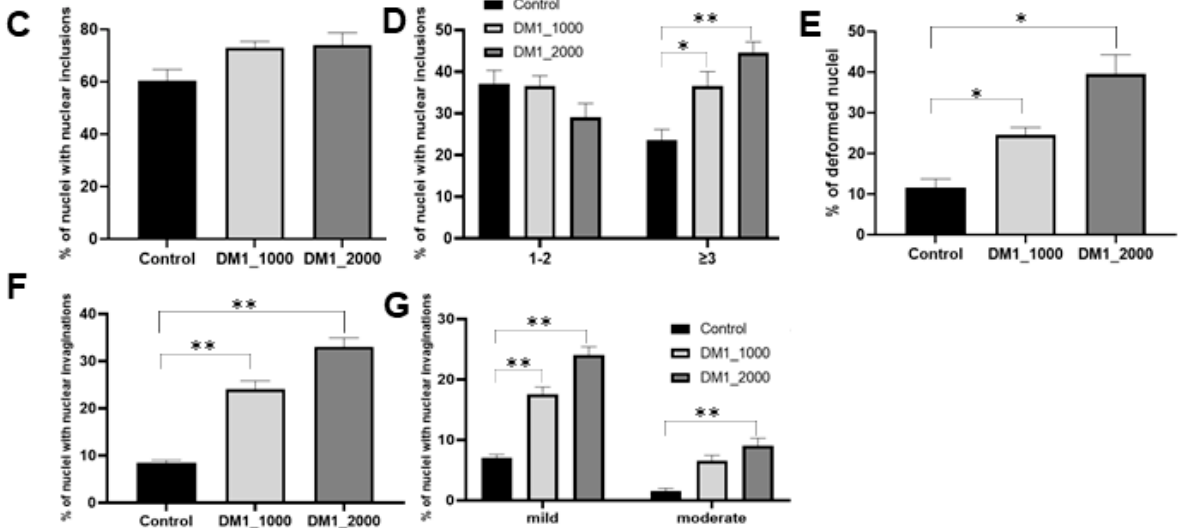
Figure 4. Intracellular protein levels and nuclear localization of emerin in DM1 patient-derived and control fibroblasts. ( A ) Intracellular emerin protein levels in DM1 patient-derived and control fibroblasts. The intracellular protein levels in DM1 patient-derived fibroblasts were estimated in relation to protein levels detected in the control condition and are presented as mean ± SEM of four independent experiments. Ponceau S staining was used to assess gel loading. The statistical analysis was performed using one-way ANOVA followed by Tukey’s multiple comparison test to compare between DM1_1000, DM1_2000 and the control groups. ( B ) Subcellular distribution of emerin in DM1 patient-derived fibroblasts and control was analysed using fluorescence microscopy. Emerin was detected using a specific primary antibody and an anti-mouse Alexa-488-conjugated secondary antibody (green). Nucleic acids were stained using DAPI (blue). Evaluation of emerin-positive ( C ) nuclei with nuclear inclusions, ( D ) nuclei with 1–2 or ≥ 3 nuclear inclusions, ( E ) deformed nuclei, ( F ) nuclear invaginations and ( G ) mild or moderate nuclear invaginations. The quantitative data are presented as mean ± SEM and were obtained by analysing 50 cells per condition from four independent experiments. The statistical analysis was performed using one-way ANOVA followed by Tukey’s multiple comparison test to compare between DM1_1000, DM1_2000 and the control groups. * p < 0.05, ** p < 0.01; Scale bar = 10 µ m; ↑ represents nuclear invaginations; ˆ represents